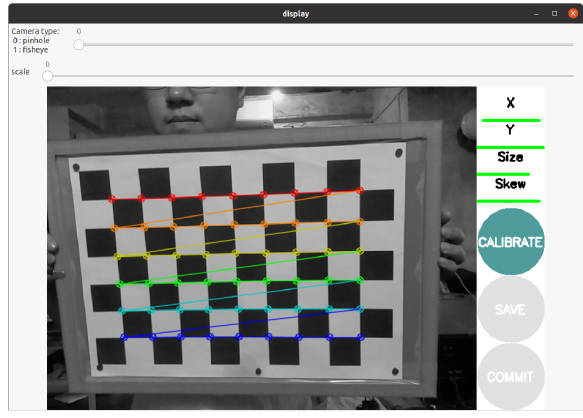
Figure 6. Camera calibration